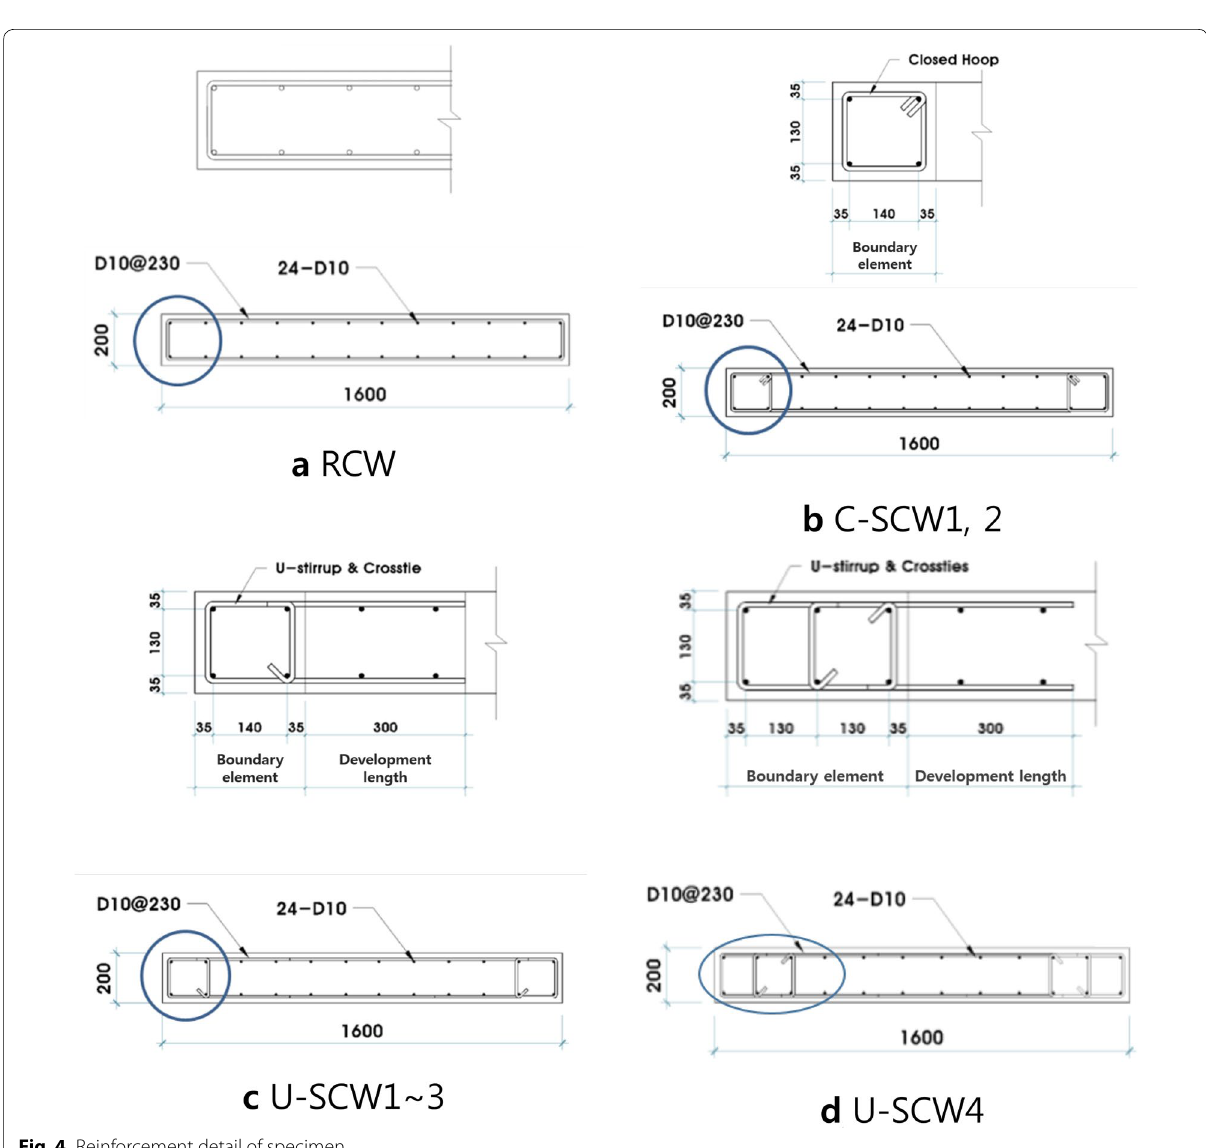
Fig. 4 Reinforcement detail of specimen.